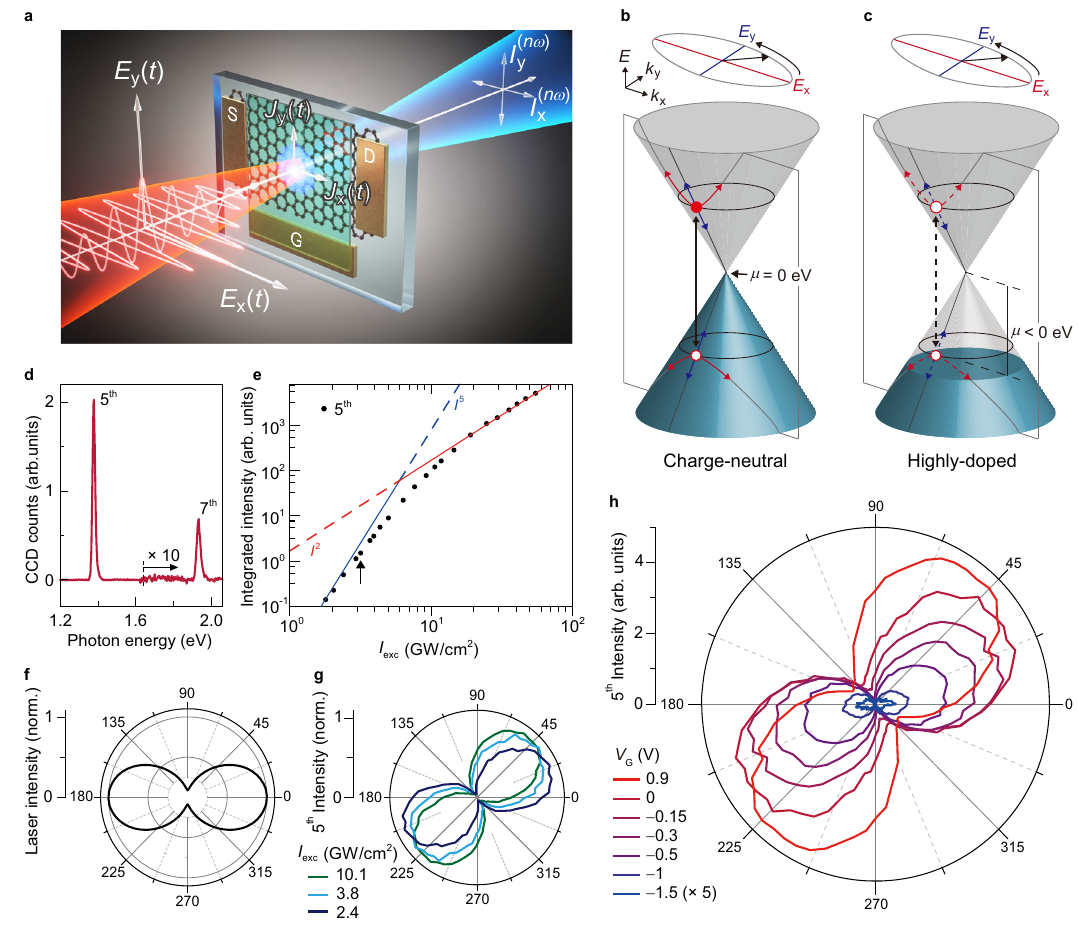
Fig. 1 | Gate-tunable HHG in graphene. a Schematic of HHG measurement. An intense mid-infrared femtosecond laser pulse E ð t Þ generates an anharmonic ultra- fast current J ð t Þ in the graphene device with ion-gel gating, radiating high harmo- nics I ð n ω Þ . b , c Schematic of chemical potential ( μ ) dependent HHG process in momentumspace.Forthecharge-neutralcase( b ), J ð t Þ isgeneratedsimultaneously by the interband transition (black solid arrow), intraband transition along the x - direction (red solid arrow), and intraband transition along the y -direction (blue solid arrow). For the highly doped case, the interband transition (black dashed arrow)andconnectedintrabandtransitions(redandbluedashedlines)areblocked due to Pauli blocking. d HHG spectrum. The fi fth and seventh harmonics are observed at 1.38 and 1.93eV, respectively, under excitation photon energy of